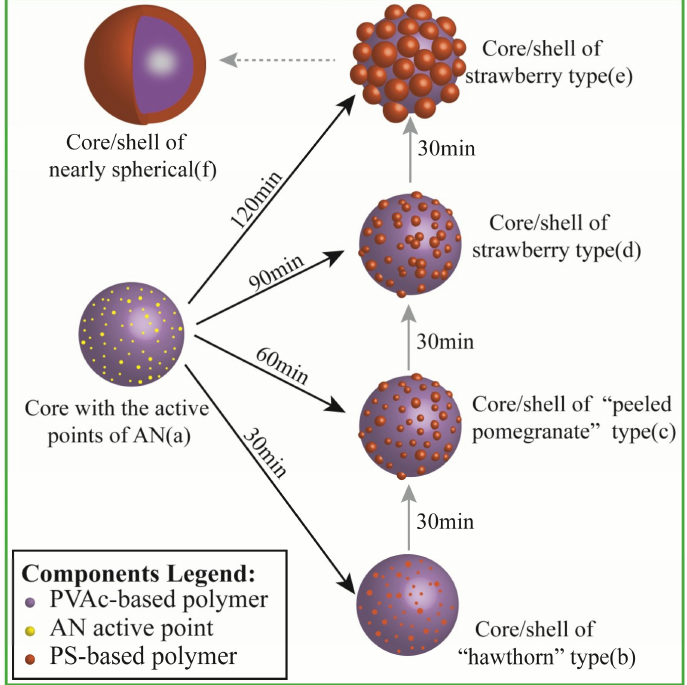
Figure 9. Formation mechanism and morphological evolution of PVAc-AN/PS inverted core-shell structured latex